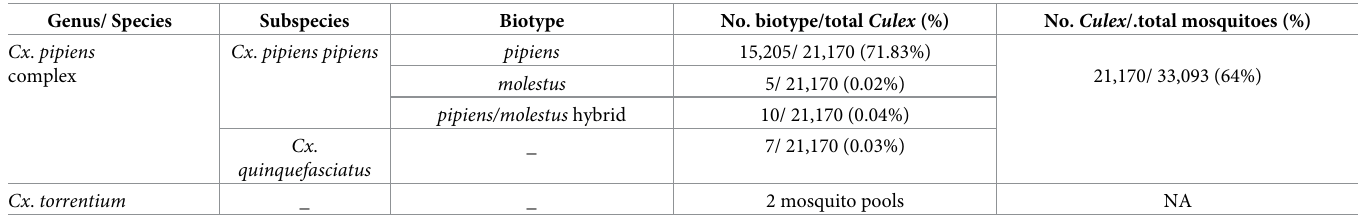
Table 1. Number of collected Cx . pipiens complex and Cx . torrentium in Iran, 2015–2016. Genus/